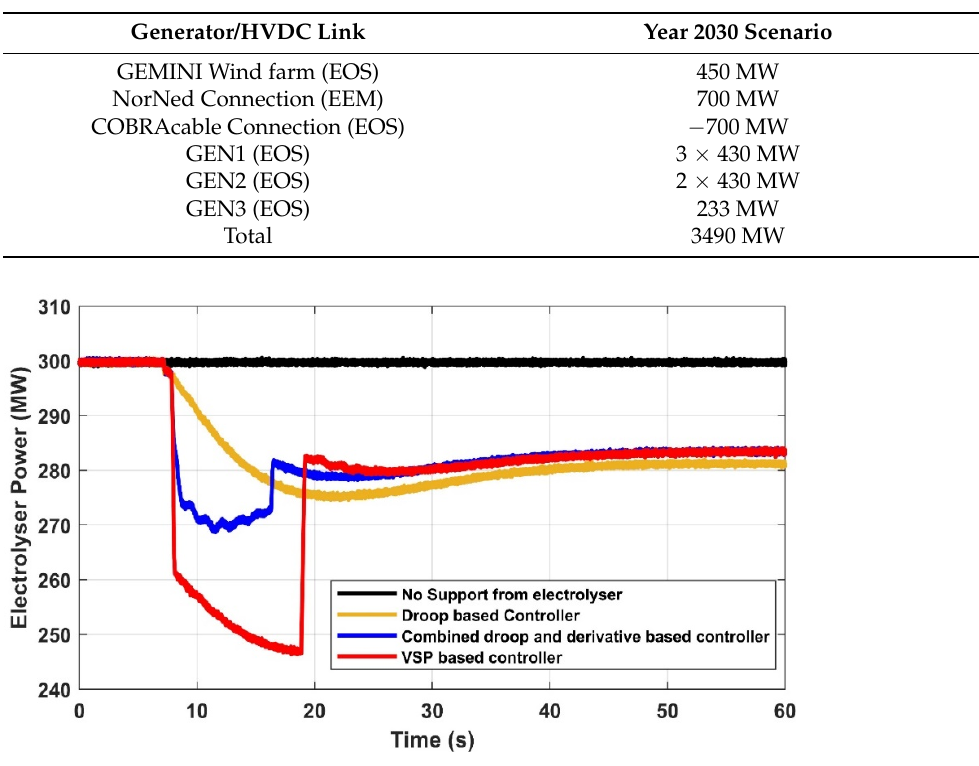
Table 1. Active power share in the N3 test system for year 2030.